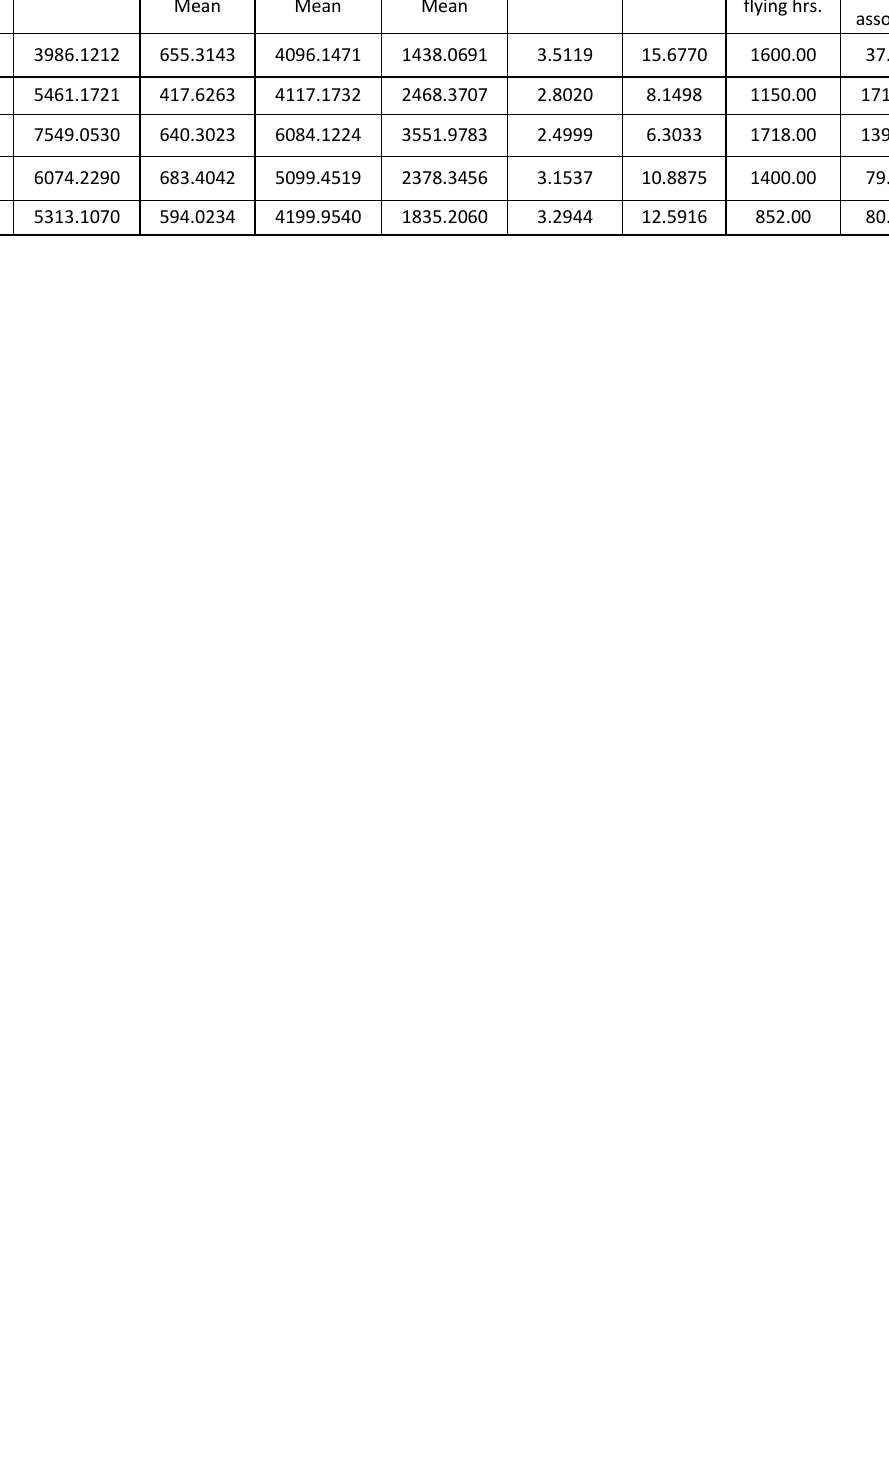
TABLE A3:.DESCRIPTIVE STATISTICS SUMMERY: ASSOCIATED NUMBER OF ACCIDENTS WITH AVERAGE FLYING HOURS PER YEAR FROM 2008 TO 2012. Mean flying Std. Err Year Std. Dev hours